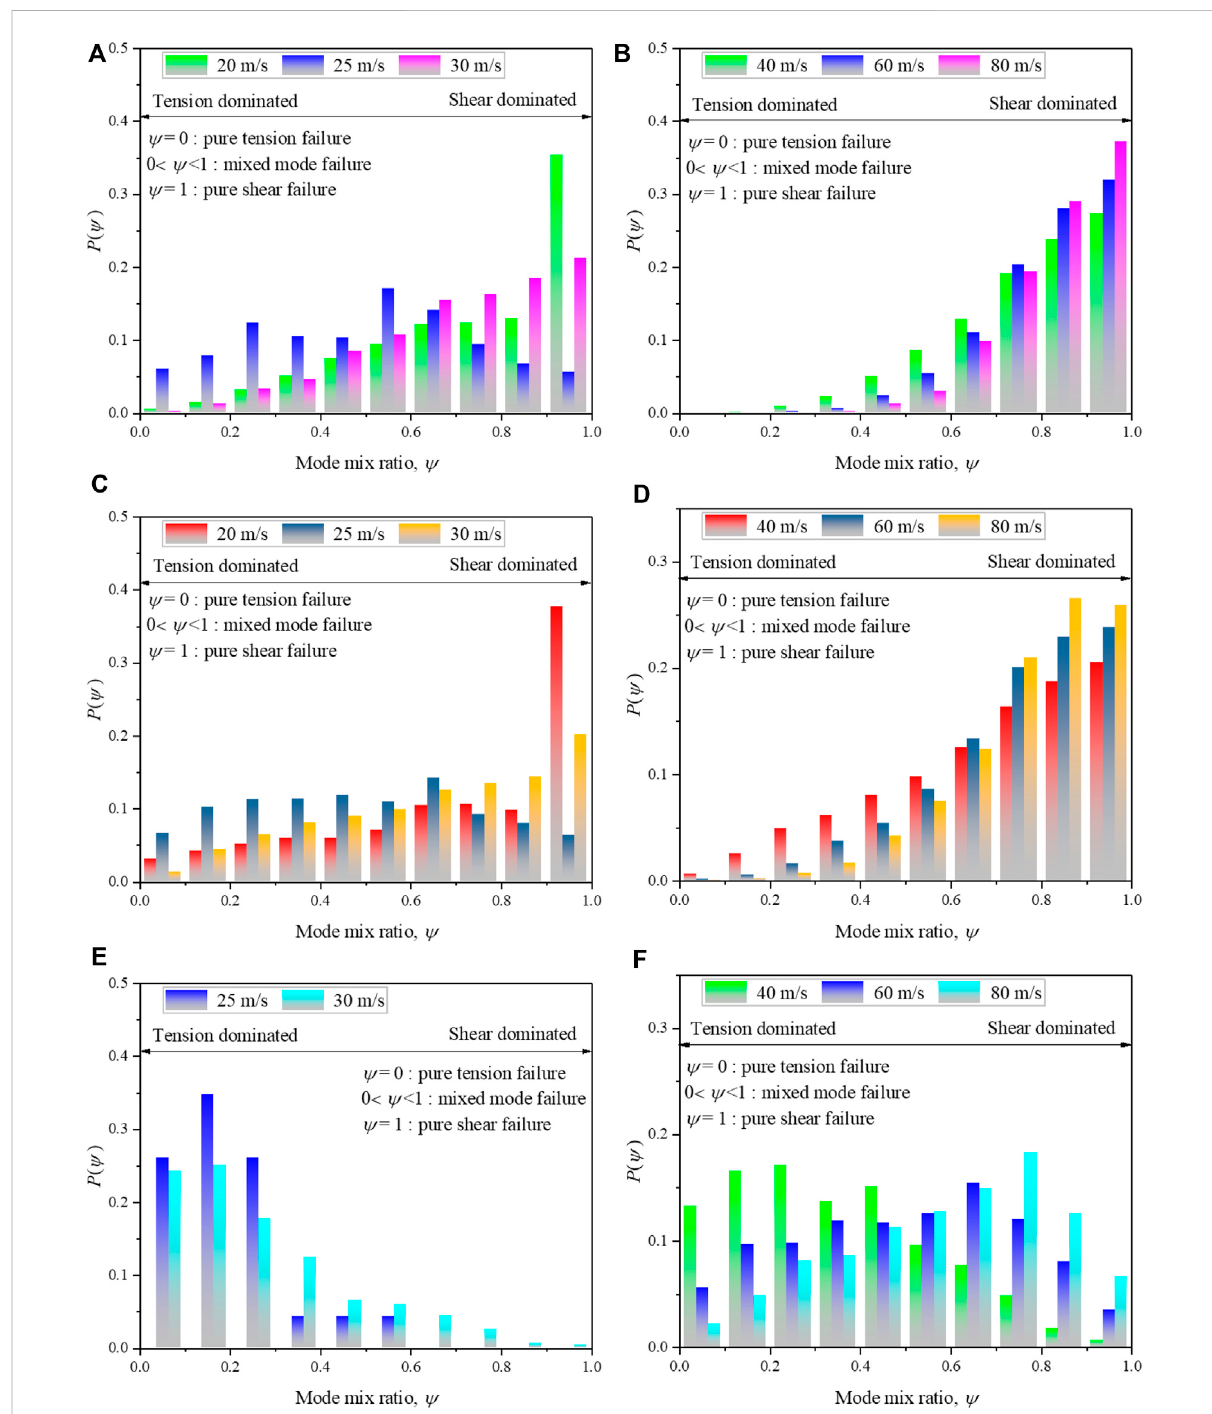
FIGURE 9 Probability distributions of the mode mix ratio of different regions of the sample under different impact velocities. (A) and (B) are the lower region, (C) and (D) are the middle region, and (E) and (F) are the upper